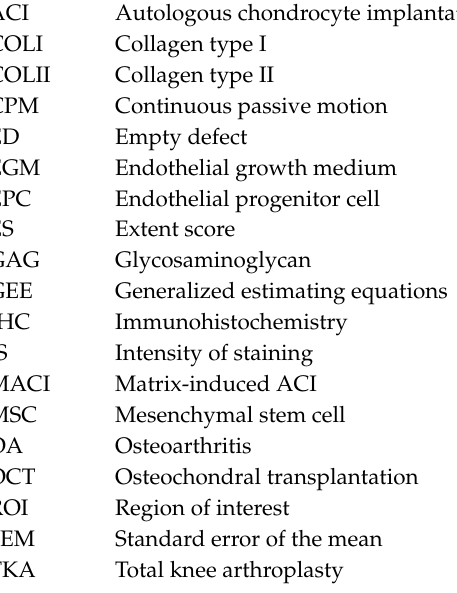
s1. Table S1. Modified Wayne’s grading scale scoring system for gross